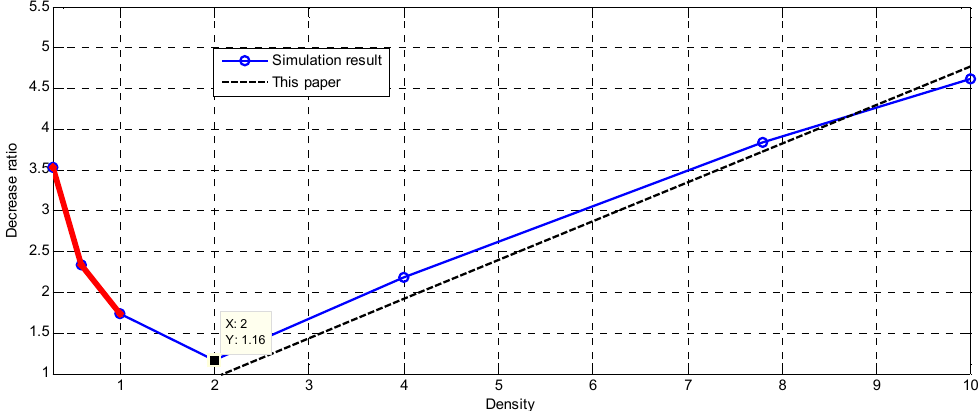
Figure 35. The plot of energy vs. time at density ρ = 10 ton / m 3 .